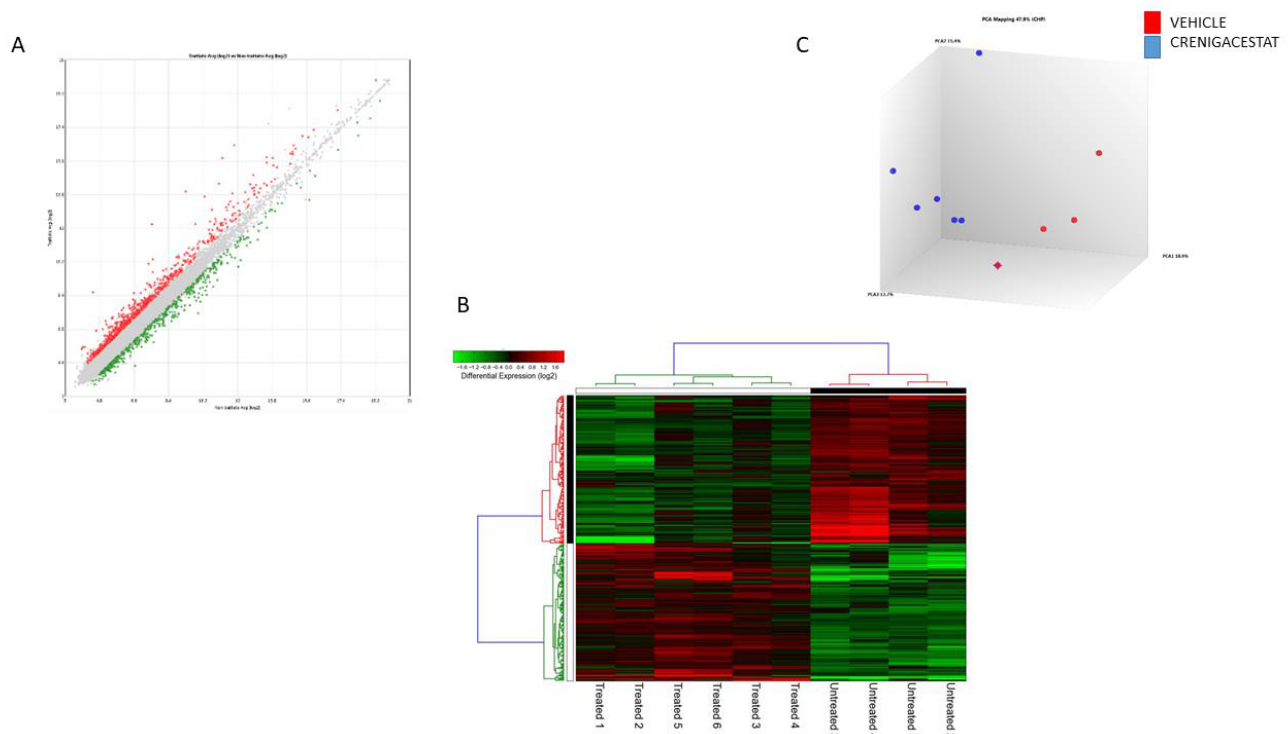
Figure 2. Global gene expression profile in HuCCT1-xenograft model treated and untreated with Crenigacestat reveals molecular changes. ( A ) PCA clearly shows the separation between treated and untreated mice. ( B ) The separation between treated and untreated mice is further confirmed by the analysis of unsupervised hierarchical clustering. Each row represents a gene, and each column represents a sample. A color code represents the relative intensity of the expression signal, where red and green indicate high and low expression, respectively, according to the scale shown on the top. ( C ) Scatterplot of all assayed probes shows the distribution of differentially expressed genes based on the expression data of treated and untreated mice, applying a cut-off p -value threshold lower than 0.005 and a fold change of 1.5. The X-axis represents the averaged log2 signal of untreated samples, and the Y-axis represents the averaged log2 signal of treated samples.